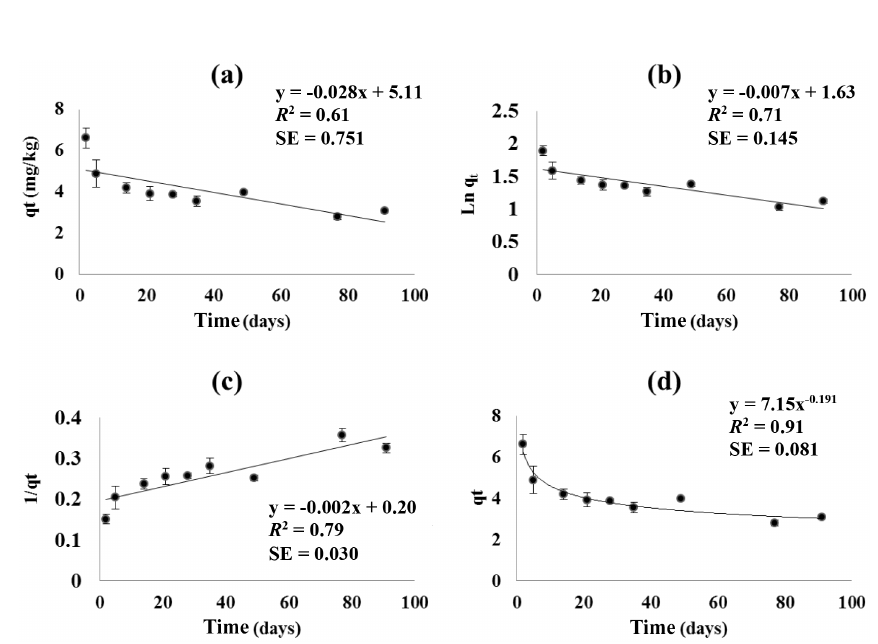
Figure 1. Amount of diethylene triamine pentaacetic acid (DTPA)-extractable copper over the long term (90 days) in the non-chelated system fitted to (a) zero-order, (b) first-order, (c) second-order, and (d) power function models ( q t denotes the amount remaining at time t (mgkg − 1 ); error bars are for standard errors computed from six data